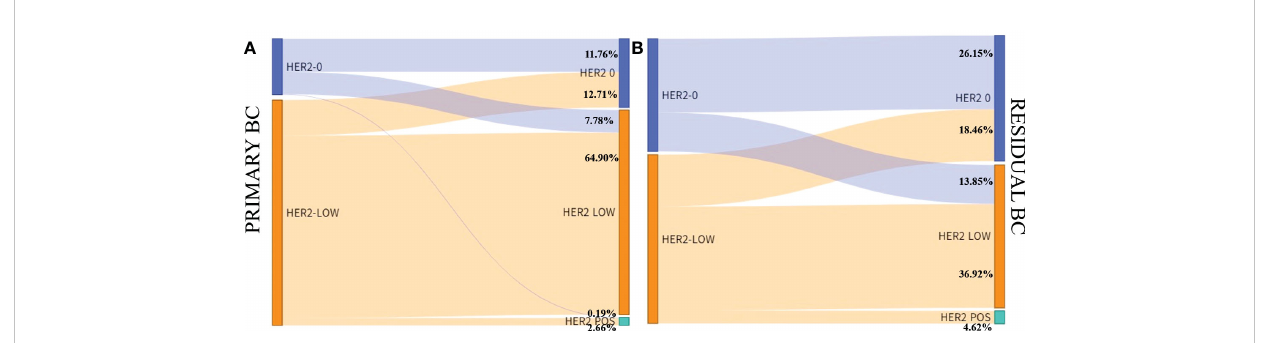
FIGURE 5 HER2 expression evolution from primary breast cancer to residual according to tumor phenotype in the HER2-low cohort. (A) Hormone receptor positive; (B) Hormone receptor negative.